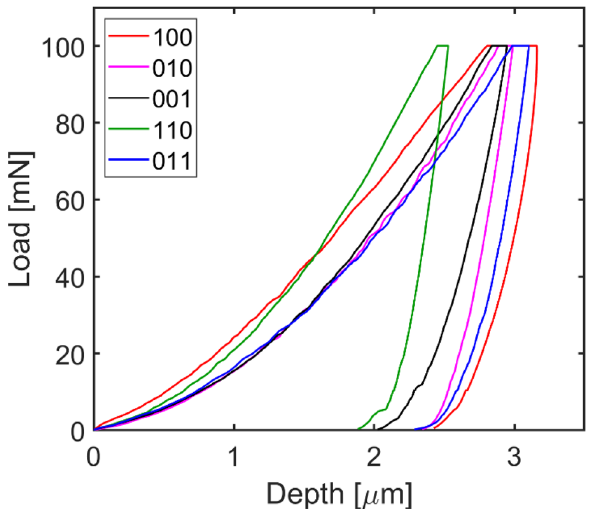
Fig. 6 Indentation load versus depth plot comparisons of different planes of β-HMX crystal